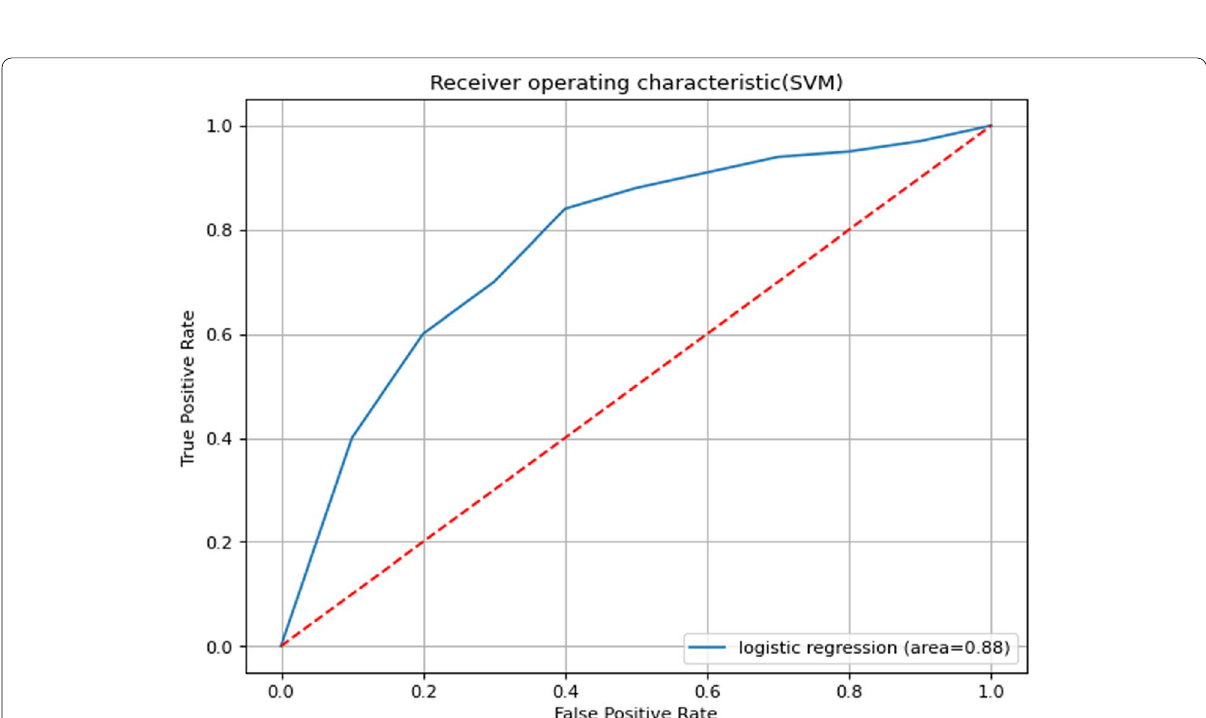
Fig. 25 ROC curve for our proposed model with